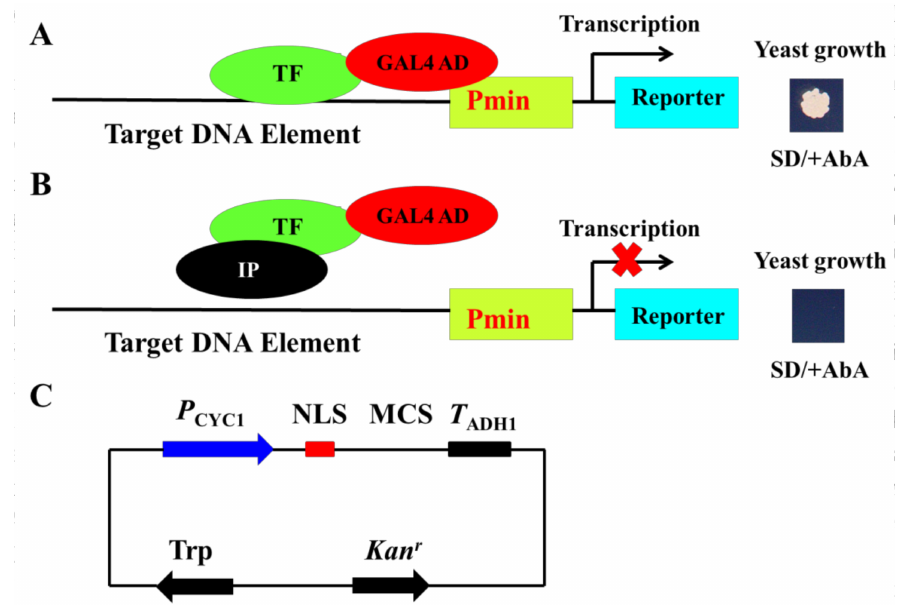
Figure 1. The principle of the newly developed method for detecting the inhibition of transcription factor (TF)-DNA binding due to protein–protein interactions in vivo. ( A ) Schematic diagram of the yeast one-hybrid system. When a TF binds to the target DNA sequence, the GAL4 activation domain (AD) can activate the reporter (AbA resistance) gene expression, which allows yeast to grow on medium supplemented with the AbA antibiotic. ( B ) Schematic diagram of the newly developed method. A TF-interacting protein (IP) is cotransformed with the TF-AD into bait-specific yeast strain. When the interaction between IP and TF inhibits TF binding to target DNA, the reporter gene will not be activated, which inhibits yeast growth on medium containing the AbA antibiotic. ( C ) Vector map of the modified pGBKT7, pmT7. The ADH1 promoter ( P ADH1 ) and GAL4 DNA-binding domain (DNA-BD) in pGBKT7 are replaced with CYC1 promoter ( P CYC1 ) and nuclear localization signal (NLS) in pmT7, respectively. 3.2. The New Method was used to Verify the Result that HFR1-PIF1 Interaction Inhibited PIF1 Binding